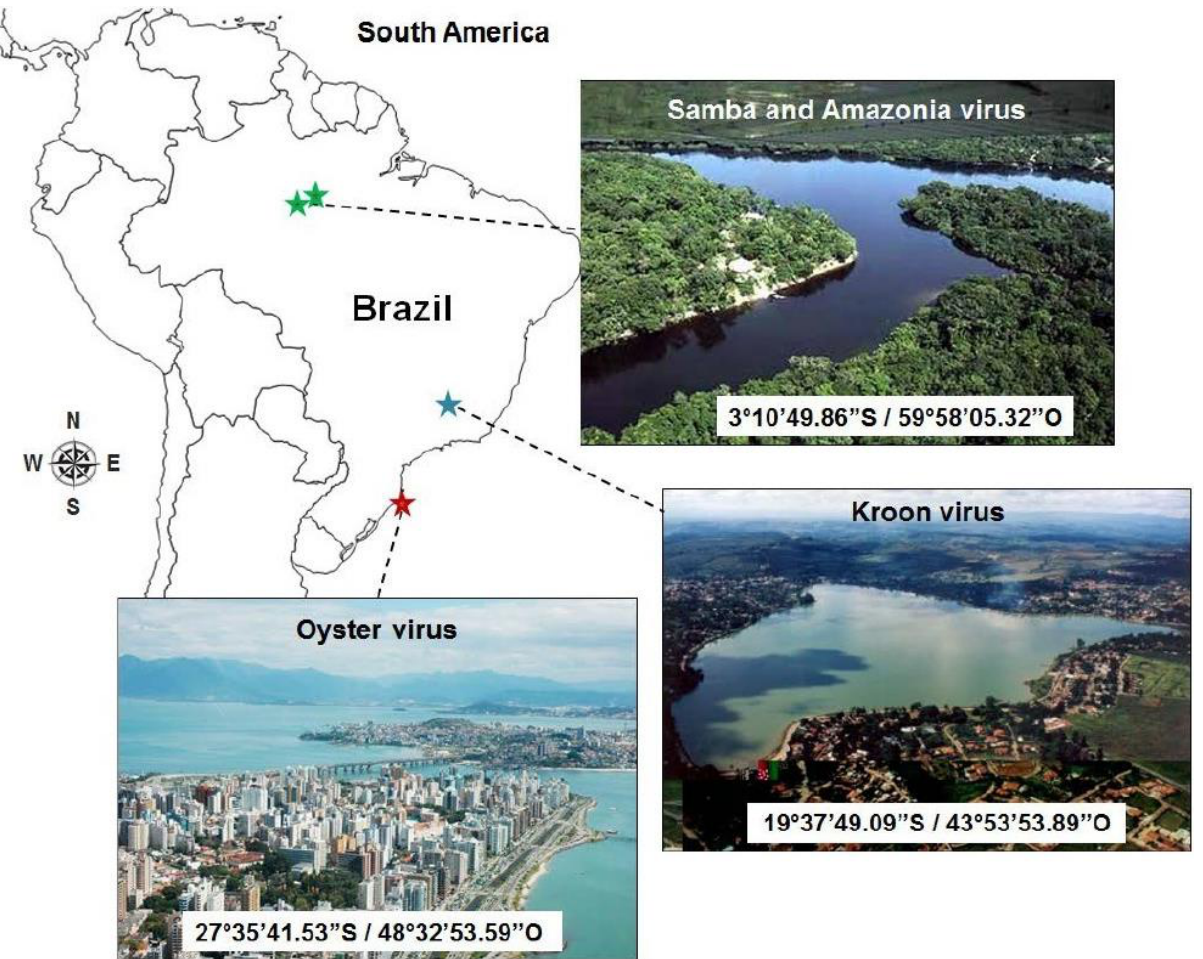
Figure 1. Geographical location, coordinates, and biome representation for each Brazilian mimivirus isolate.